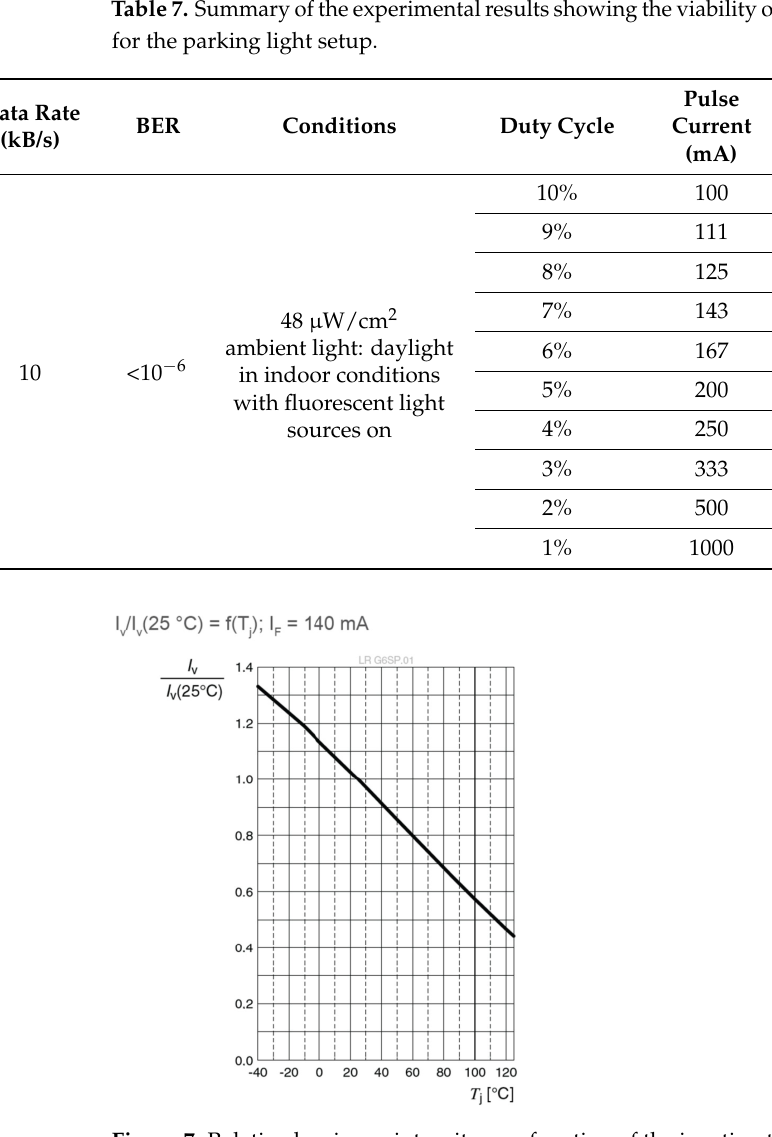
Figure 7. Relative luminous intensity as a function of the junction temperature